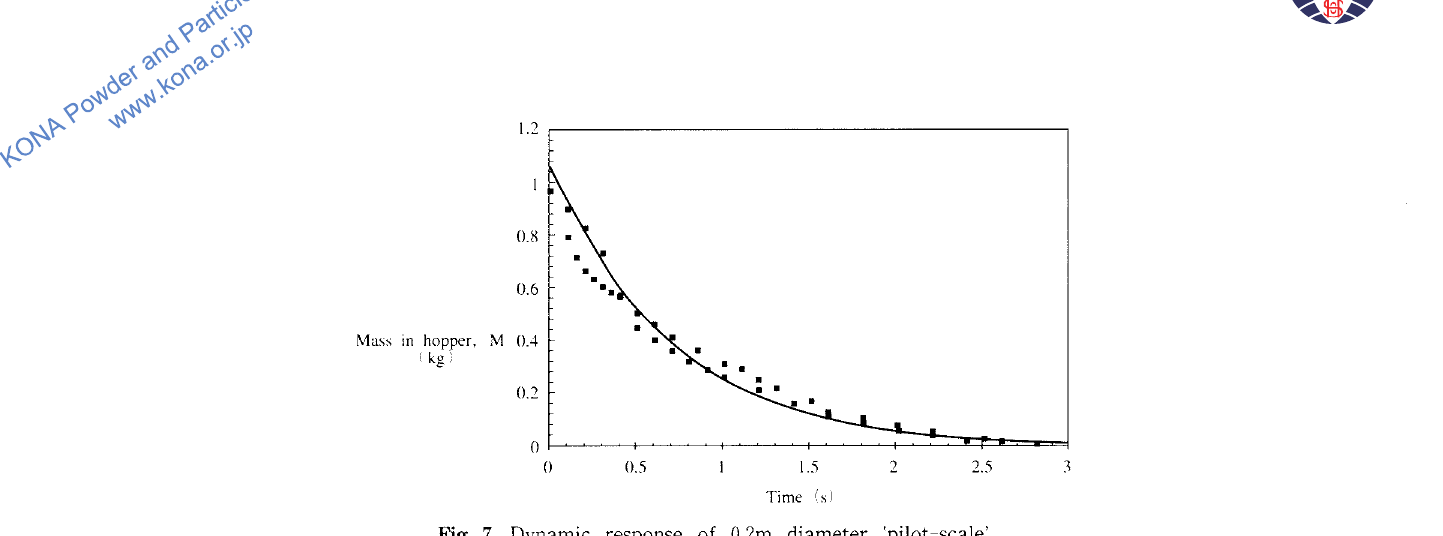
Fig. 7 Dynamic response of 0.2m diameter 'pilot-scale' SMF to cessati'on of flow, with FCC, 71 flm mean diameter, Harris et al. (1992).